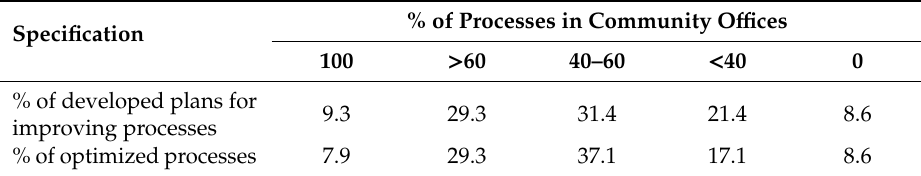
Table 1. The level of process optimization in the surveyed community o ffi ces (n =